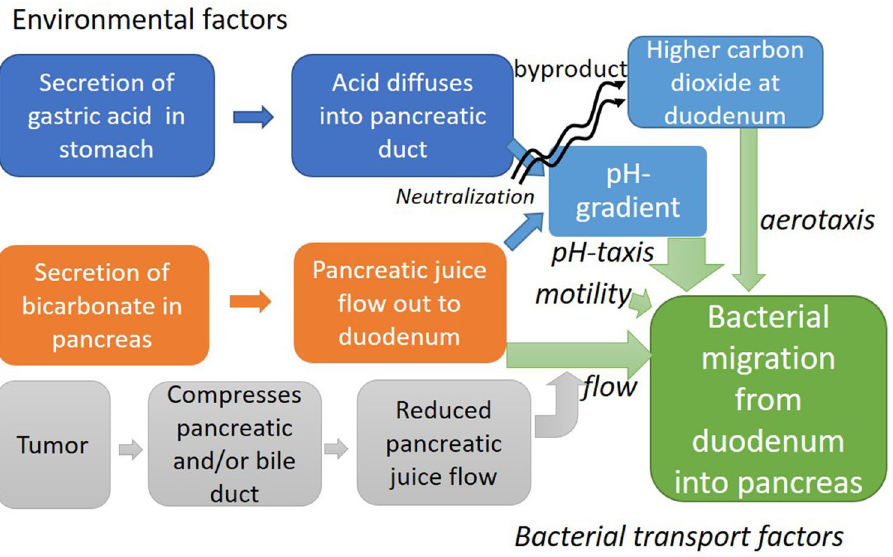
Figure 8. Environmental factors in the upper gastrointestinal tract affect migration of aerobic bacteria from the duodenum into the pancreas via bacterial taxes. The pH-taxis under the pH-gradient between acidic duodenum fluid and pancreatic juice at slightly alkaline pH is the major driving force for migration to pancreas. Aerotaxis away from higher carbon dioxide at the duodenum also increases migration slightly. This migration is counteracted by pancreatic and bile flow but a solid tumor on pancreatic duct at pancreatic head reduces the fluid flow, and thus facilitates